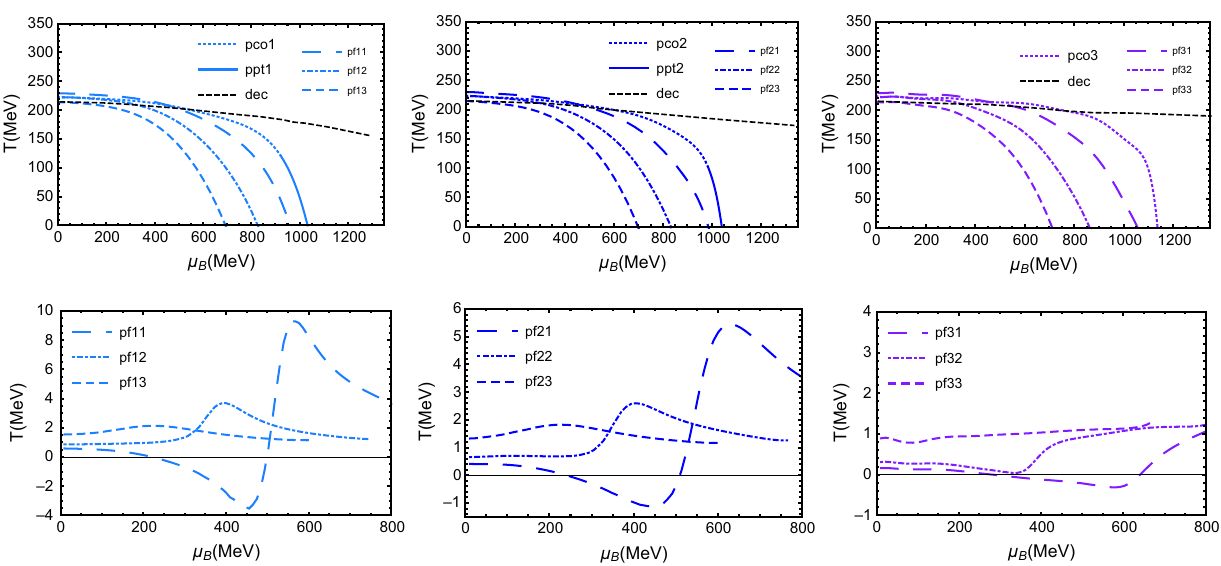
Fig. 5 (Above) The deconfinement phase transition line indicated by short-dashed line and the chiral phase transition line in the PNJL model with the 1st order phase transition line and the crossover indicated by solid and dotted lines, respectively. Three different freeze-out lines for each model PNJL-I (with I = 1, 2, 3) are defined in Eq.(18): (1) pfI1 starts from the back ridge of the chiral phase boundary, goes through the negative region and then crosses the foot of the CEP mountain; (2)